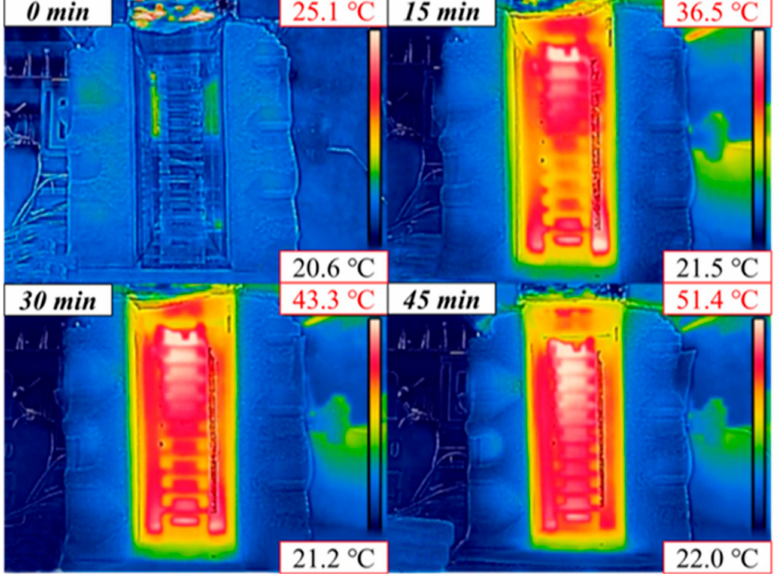
Figure 7. Infrared images of the 3D solar photothermal energy generator with the Fe 3 O 4 @Cu 2 − x S films (85% AVT) at different time intervals. Note that the temperature can continue to rise if the light source is kept on for extended times [62]. Reprinted with permission from Lyu, Mengyao, Jou Lin, John Krupczak, and Donglu Shi. “Solar harvesting through multilayer spectral selective iron oxide and porphyrin transparent thin films for photothermal energy generation.” Advanced Sustainable Systems 5, no. 6 (2021): 2100006. Copyright 2023 John Wiley and